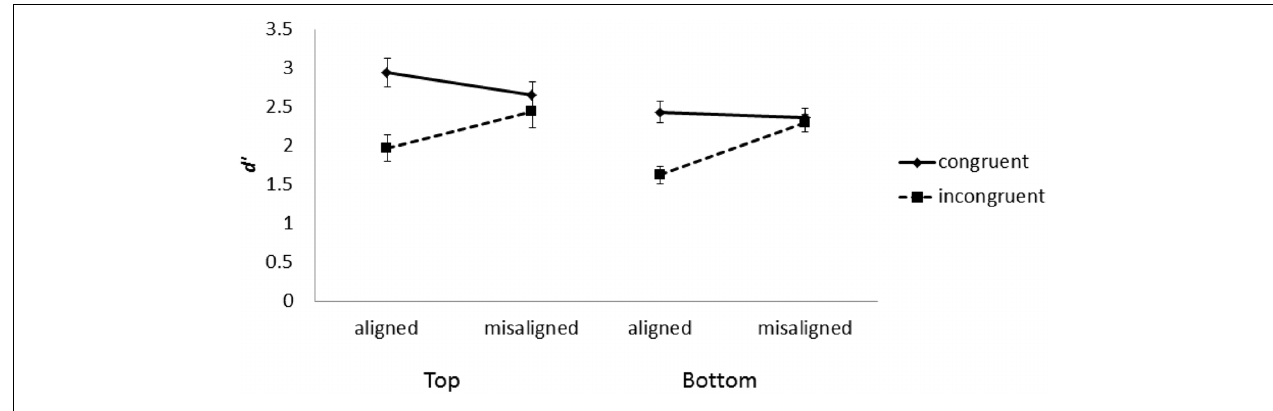
FIGURE 7 | Mean d ’ as a function face part, alignment, and congruency in Experiment 2. Error bars indicate ± 1 standard error of mean.